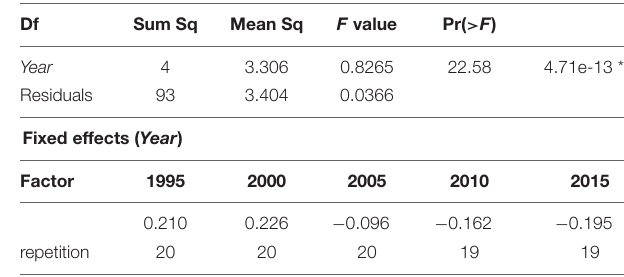
TABLE 6 | Summary of ANOVA results for logarithmically transformed OW/FL -values with year of sampling ( Year ) as fixed factor.